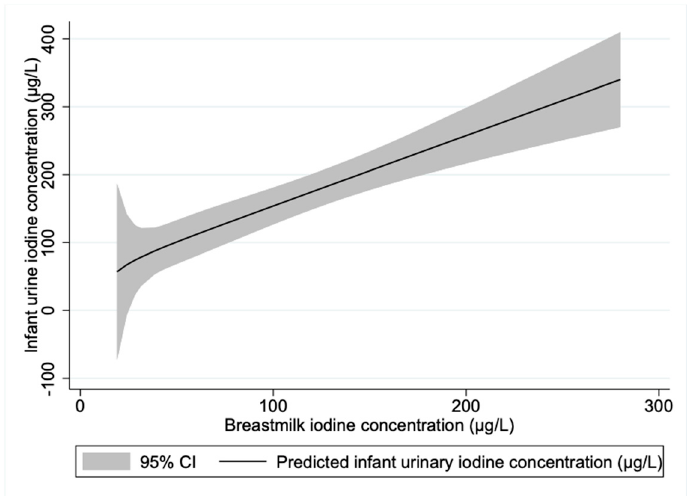
Figure 3. Prediction plot of infant urinary iodine concentration by maternal breastmilk iodine concentration for exclusively breastfed infants. n = 56.